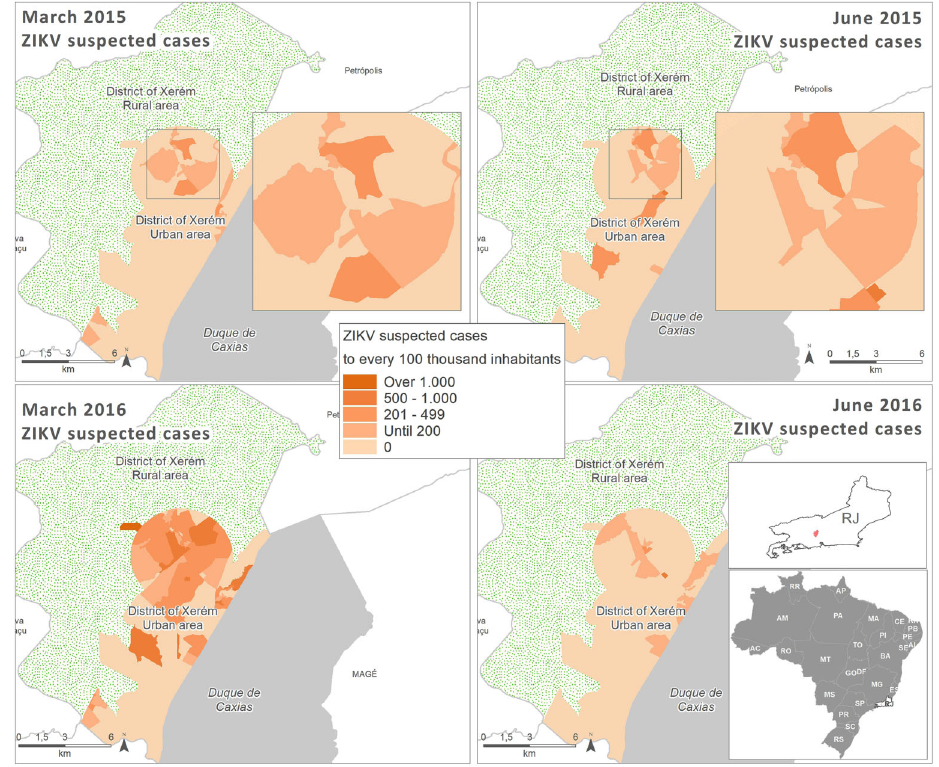
Figure 1. Spatial distribution of Zika virus (ZIKV) suspected cases in March and June 2015 and 2016 in Xerem, Duque de Caxias,